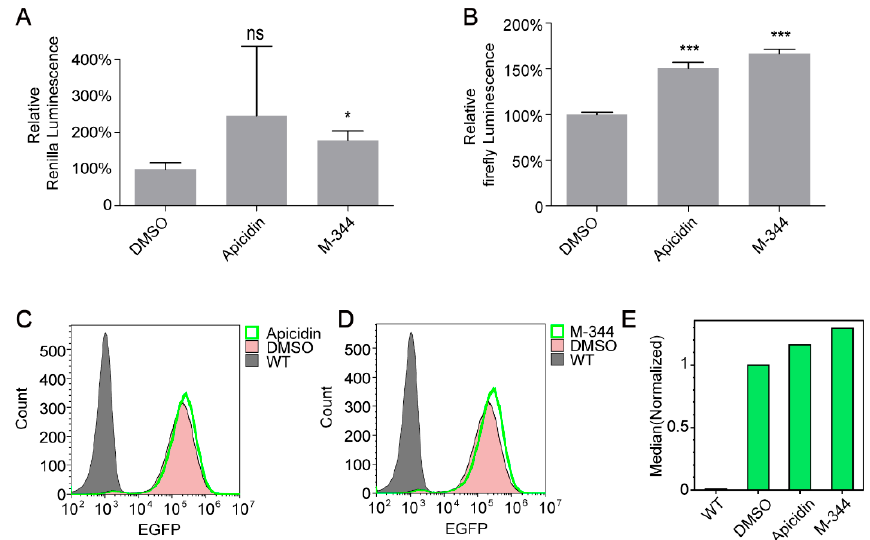
Figure 4. Apicidin and M-344 enhanced the expression of recombinant proteins from genes integrated into the genome. ( A ) Validation of the effects of Apicidin ( A ) and M-344 ( B ) using relative luminescence reporter assays. ( C – E ) Validation of the effects of Apicidin and M-344 using flow cytometry analysis. All statistical analyses were performed using Student’s t-tests (ns, not significant; * p < 0.05, *** p < 0.001).